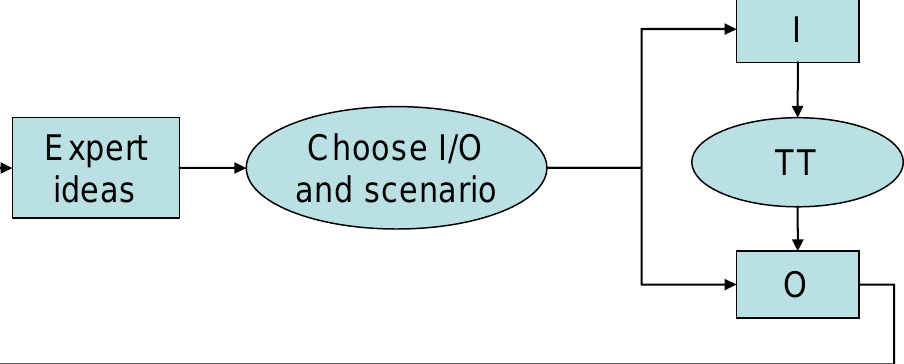
Figure 3. Combination of model results and expert